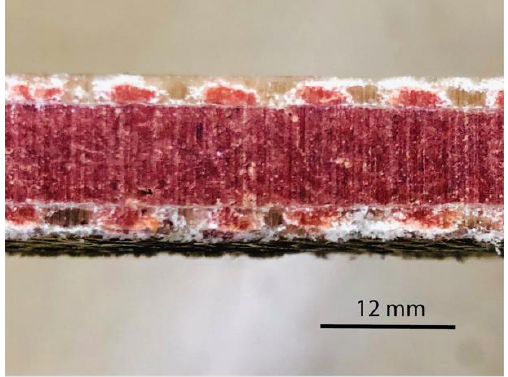
Figure 2. Close up image of the cross-section of composite tooling materials.